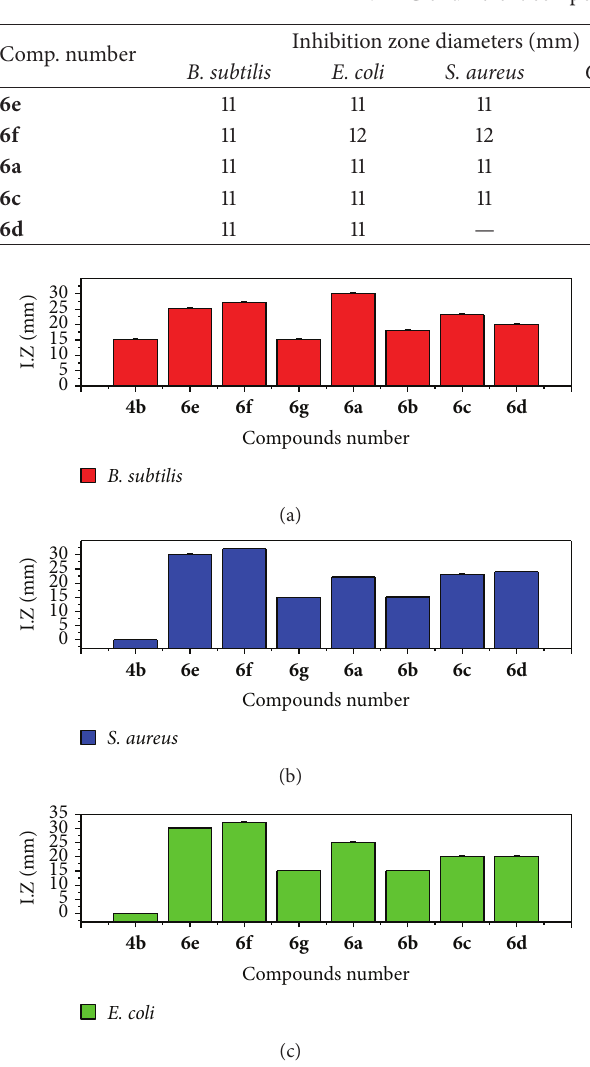
Figure 1: Antibacterial activity of the synthesized compounds at concentration of 10 mg/mL: (a) B. subtilis , (b) S. aureus and (c) E. coli .